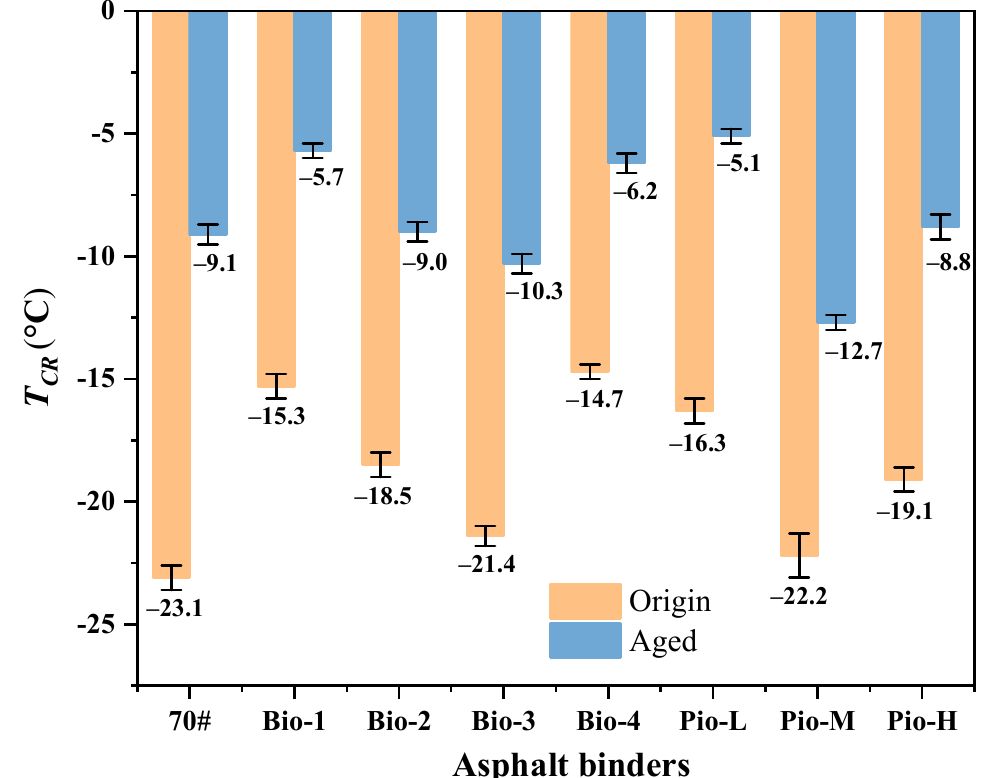
Figure 8. Critical cracking temperature ( T CR ) of all the asphalt